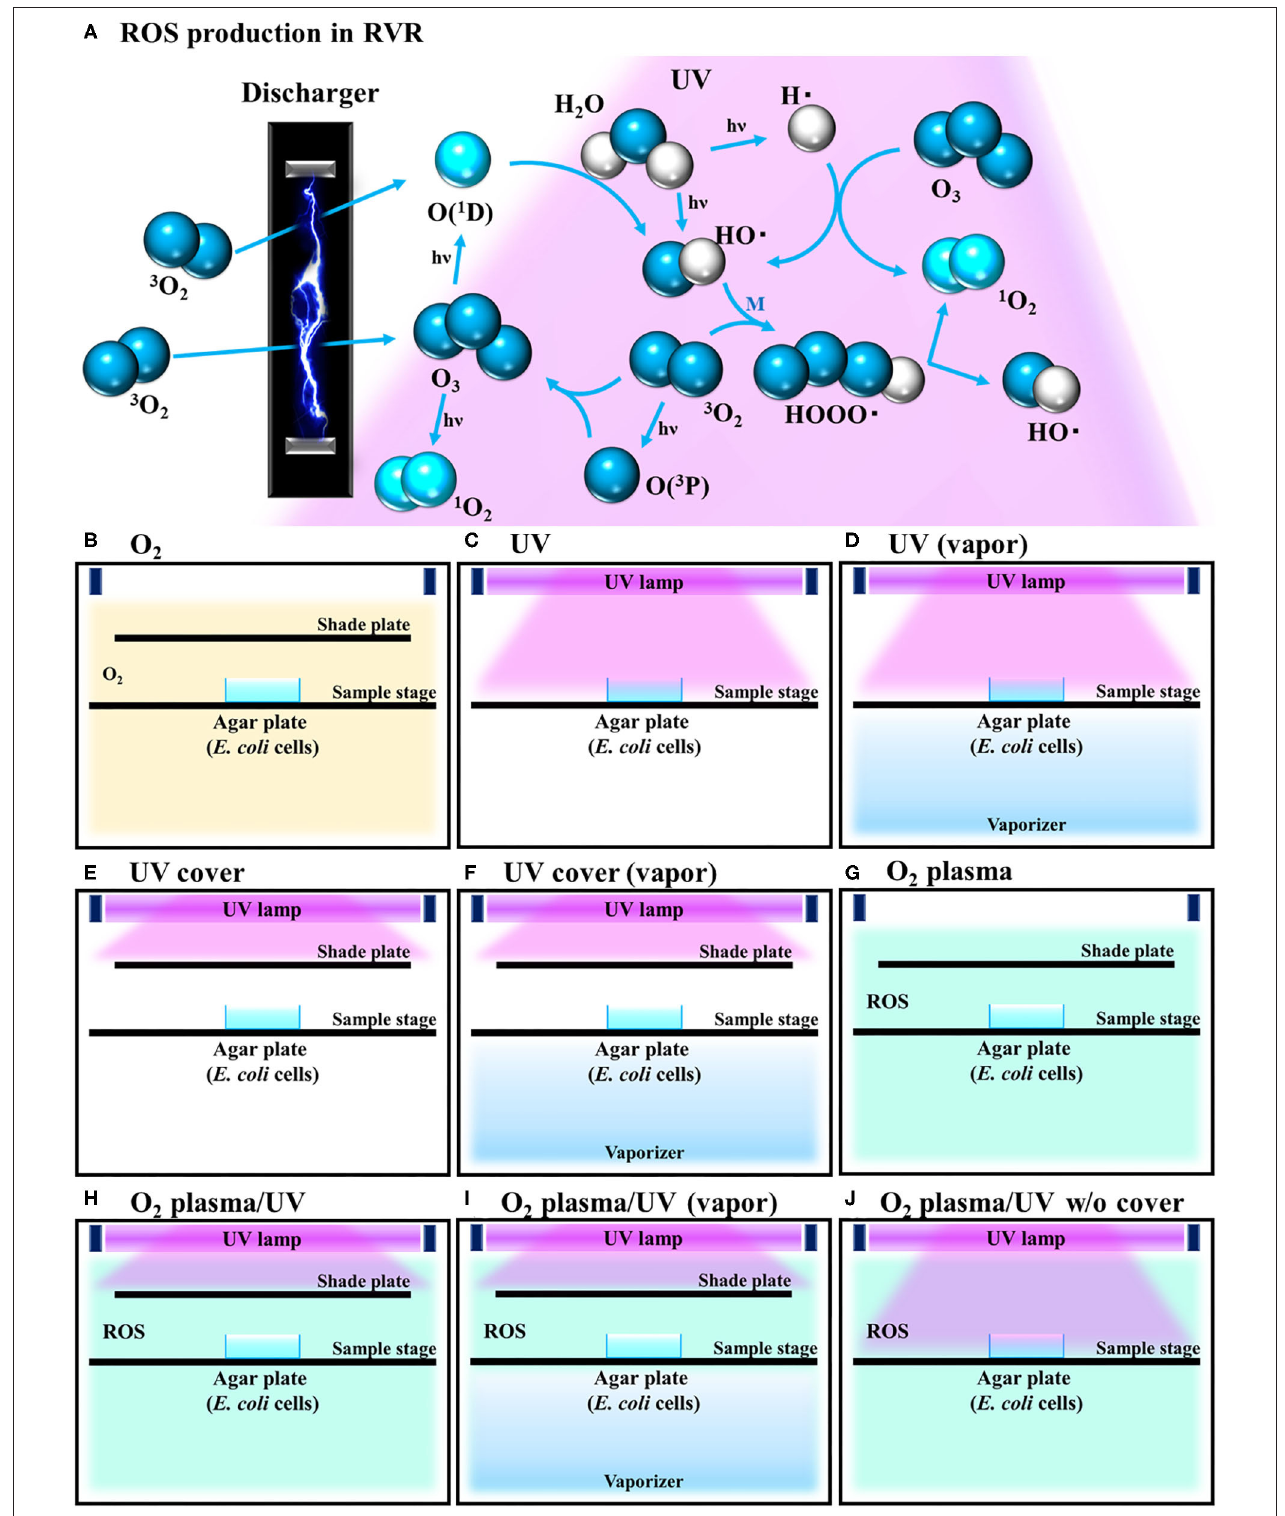
FIGURE 1 | Schematic illustration of reactive oxygen species (ROS) production reaction under various radical vapor reactor (RVR) conditions. (A) ROS production reaction pathway. Oxygen is ozonized by discharging. Ozone is degraded to atomic oxygen and singlet oxygen by UV irradiation. Singlet oxygen reacts with H 2 O to